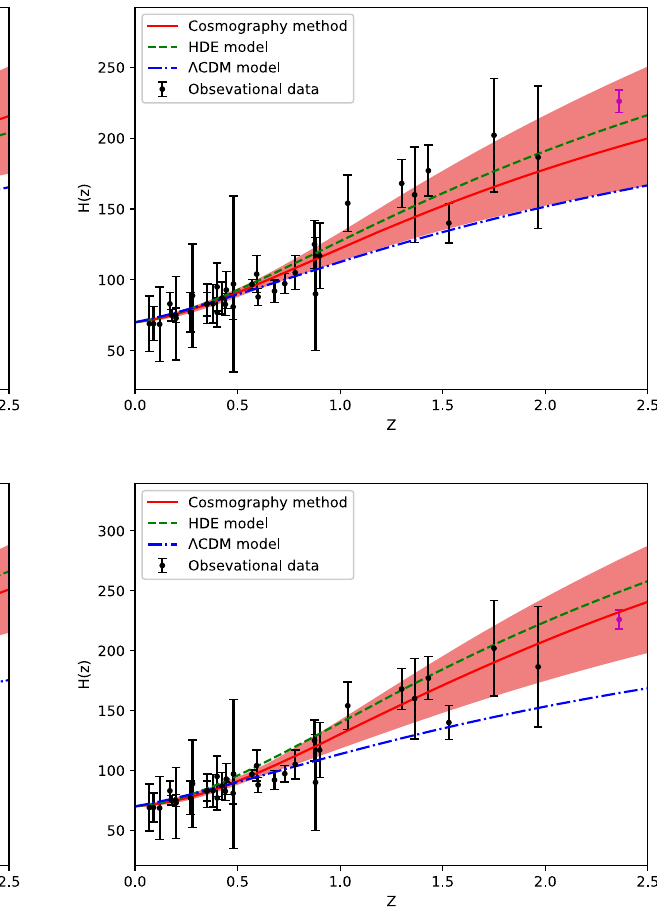
Fig. 3 The reconstructed Hubble parameter H ( z ) based on the best- fit values of the cosmographic parameters q 0 and j 0 for the model- independentapproach,HDEand Λ CDMscenarios.Theredbandshows the3 − σ confidenceregionofthereconstructedHubbleparameterinthe